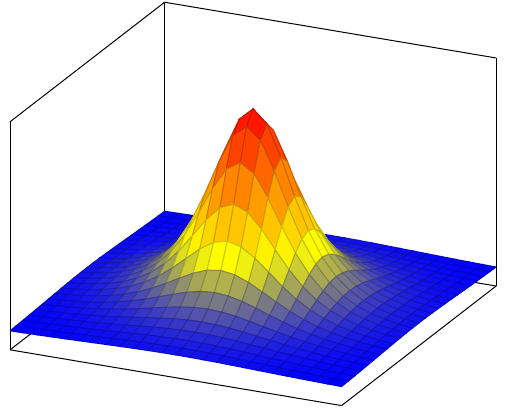
Figure 1 . A single Jackiw-Pi